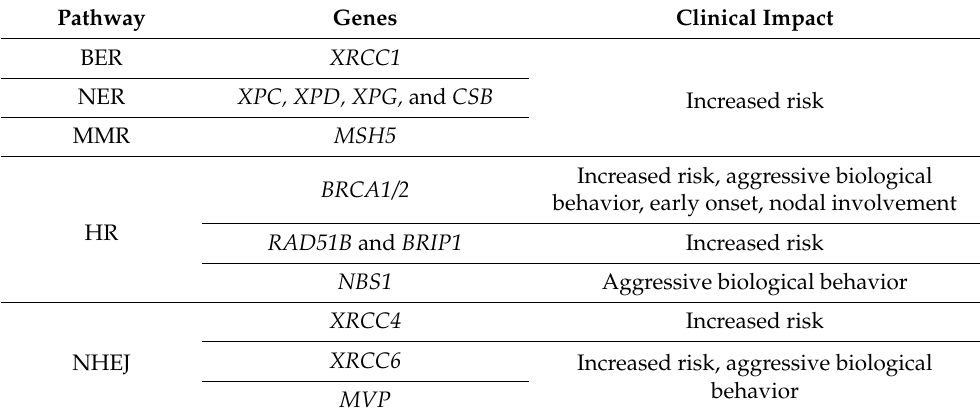
Table 1. Single-nucleotide polymorphisms and germline DDR gene mutations in